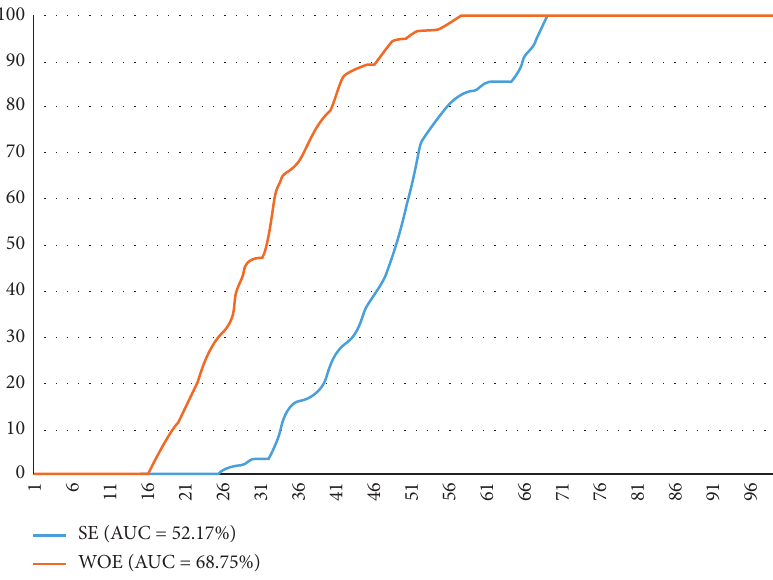
Figure 7: Validation of the WOE and SE models using ROC